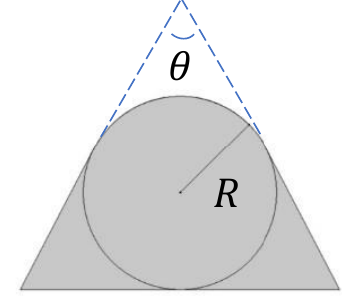
Figure 3. Schematic cross-section (in light grey) of the piston channel with a radius of curvature R at the bottom of the channel. θ is the opening angle.